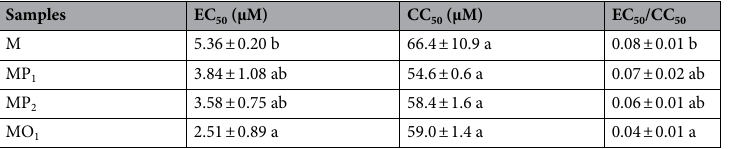
Table 1. EC 50 , CC 50 and EC 50 /CC 50 values of M, MP 1 , MP 2 , and MO 1 mixtures in differentiated PC-12 cells. Different letters in each column are significantly different (Tukey’s test, p < 0.05).